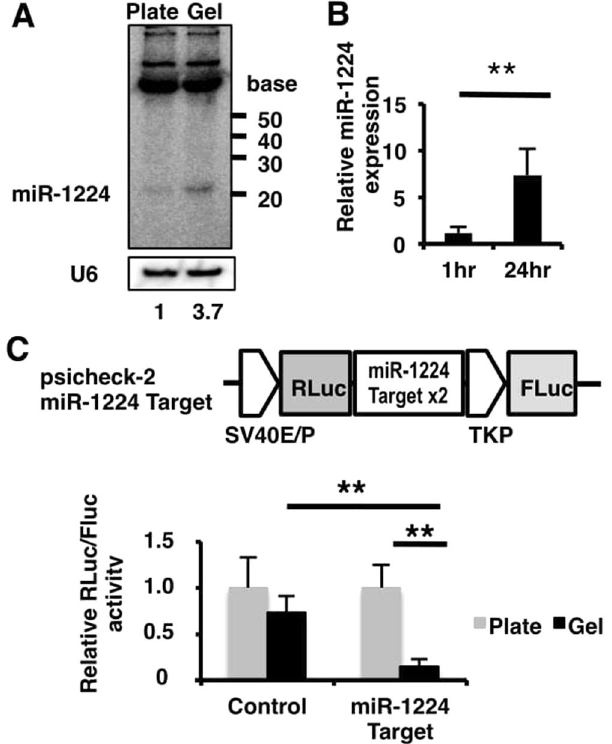
Figure 1. miR-1224 expression was upregulated during in vitro angiogenesis. ( A ) Northern blot analysis of miR-1224 expression in P-HUVECs (Plate) and M-HUVECs (Gel). The relative signal intensity of M-HUVECs to P-HUVECs is indicated. Uncropped versions of gels are provided in Supplementary Information. ( B ) qRT- PCR analysis of miR-1224 expression in M-HUVECs. Fold expression was calculated relative to one hour. Bars show the means ± S.D. with ** p < 0.01 (n = 3). ( C ) Schematic diagram of the sensor plasmid (upper panel). Reporter assay in sensor plasmid–transfected HUVECs. Normalized renilla-luciferase levels (Rluc/Fluc) in M-HUVECs are shown as relative values to P-HUVECs (lower panel). Bars show the means ± S.D. with ** p < 0.01 (n =